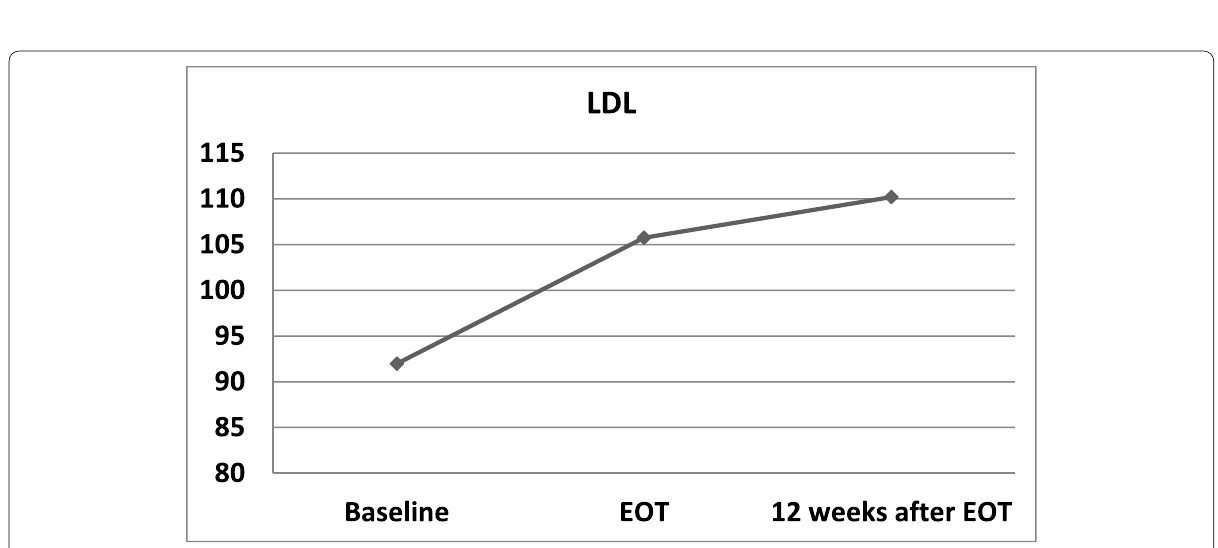
Fig. 2 Changes in serum LDL over the course of the